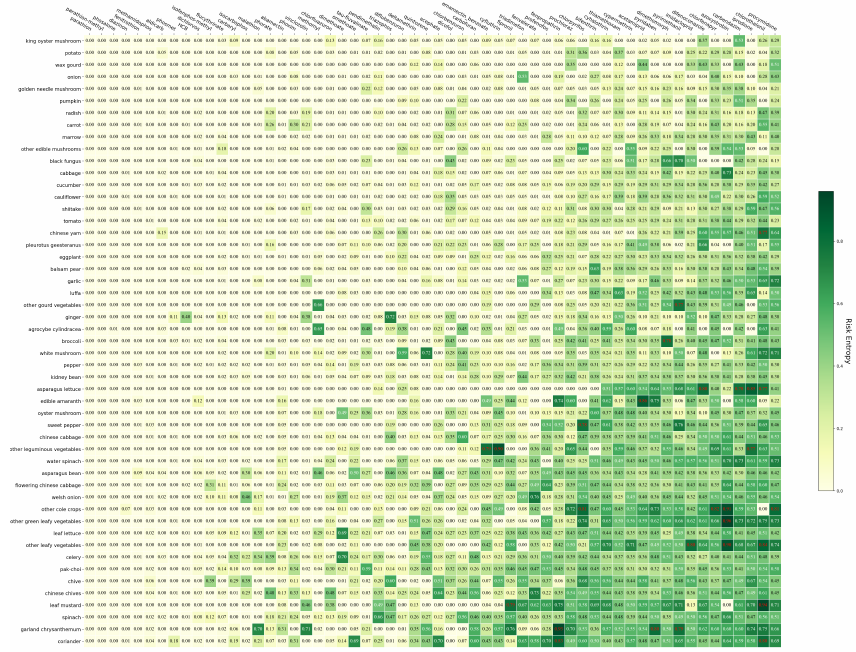
Figure 4. Heat map of the risk entropy of pesticide, the row labels are the names of 51 agricultural products and the columns are labelled with 58 indicators of pesticide residue detection. Darker colours indicate higher values of the risk